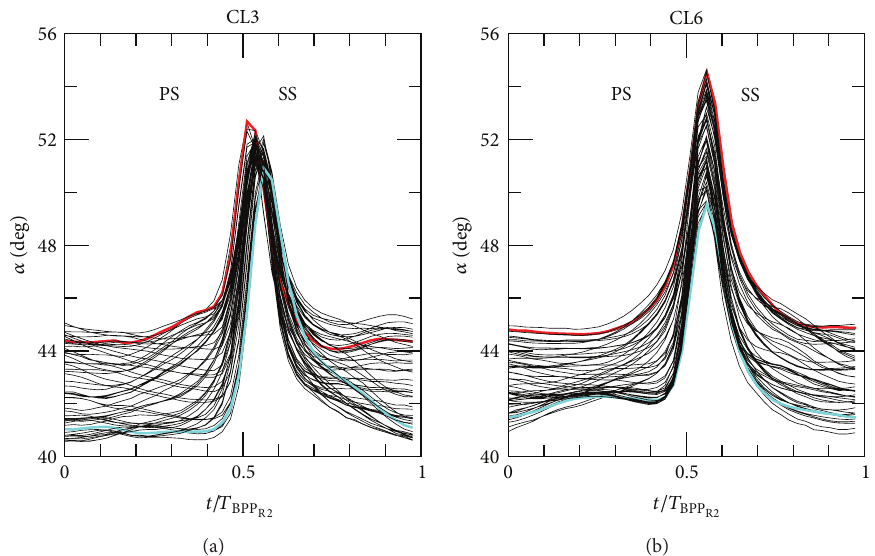
Figure 10: R2 mean wakes at 70% Span. The red wake was measured near the S2 LE, and the blue wake near